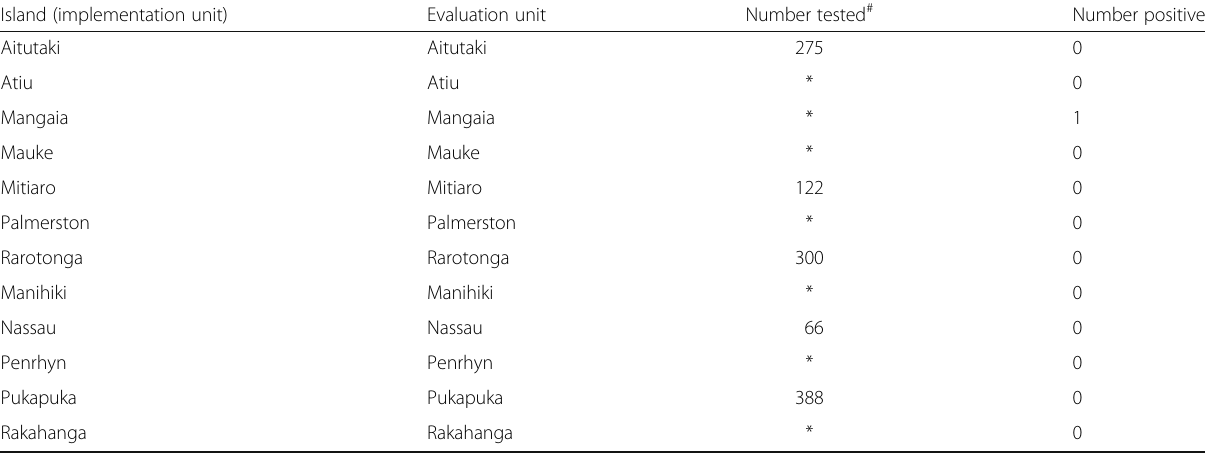
Table 5 Post-MDA surveillance survey (2013 – 2014) Island (implementation